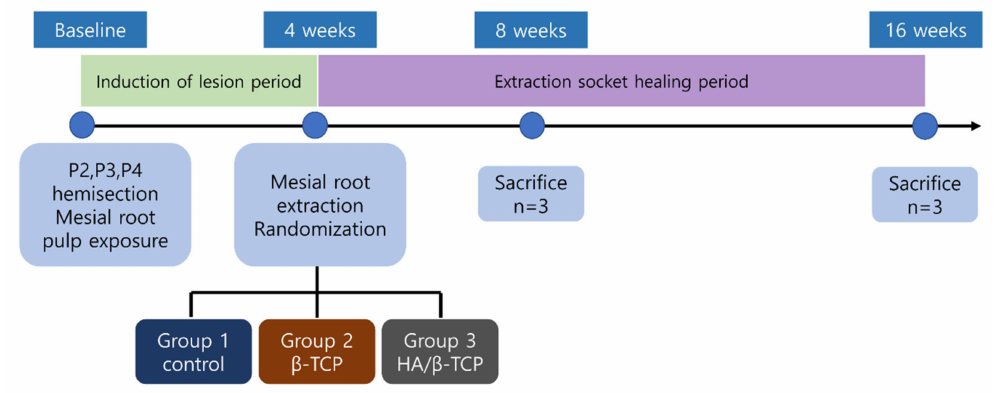
Figure 1. Study flowchart. β -TCP: β -tricalcium phosphate, HA: